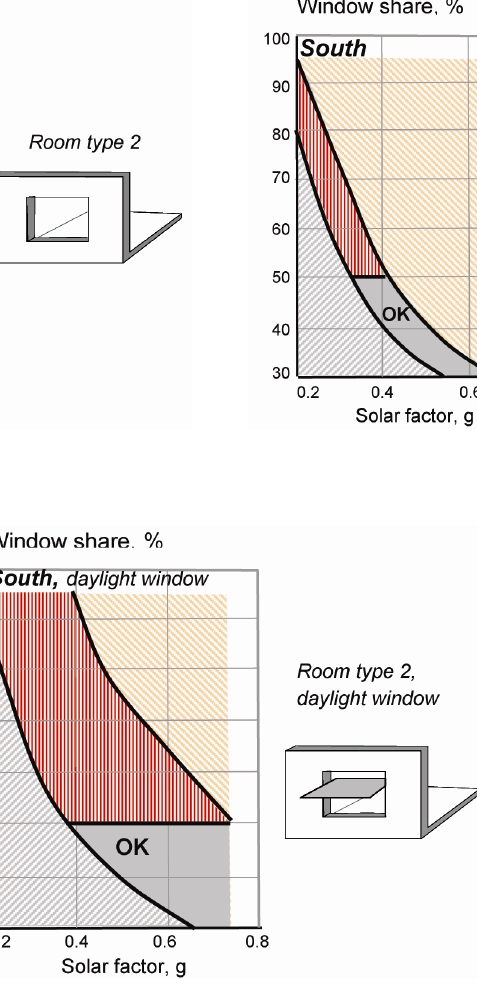
Fig. 18. Possible combinations of window glass share and solar factor for room type 1 that fulfil the requirements for a cooling power 2 2 demand below 100 W/m , a heating power demand below 30 W/m , a daylight factor above 2, and a difference between the highest 2 and lowest daylight factors of less than 20. Glass U-value = 1.2 W/(m